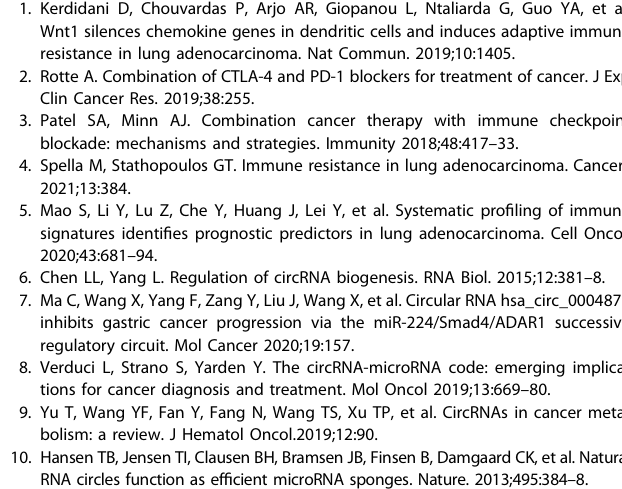
of combination treatment of C-021(CCL22 inhibitor) and anti-PD-1. When the tumor size reached approximately 100 mm 3 , the mice were injected in the tail vein with a PD-1 monoclonal IgG antibody (Hengrui Medicine Company, Lianyungang, China) at 100 μ g per dose, or C-021 (Tocris, Bristol, UK) at 5 mg/kg dose [40], or combination injection of anti-PD-1 and C-021. Animal experiments were performed according to the Guide for the Care and Use of Laboratory Animals.